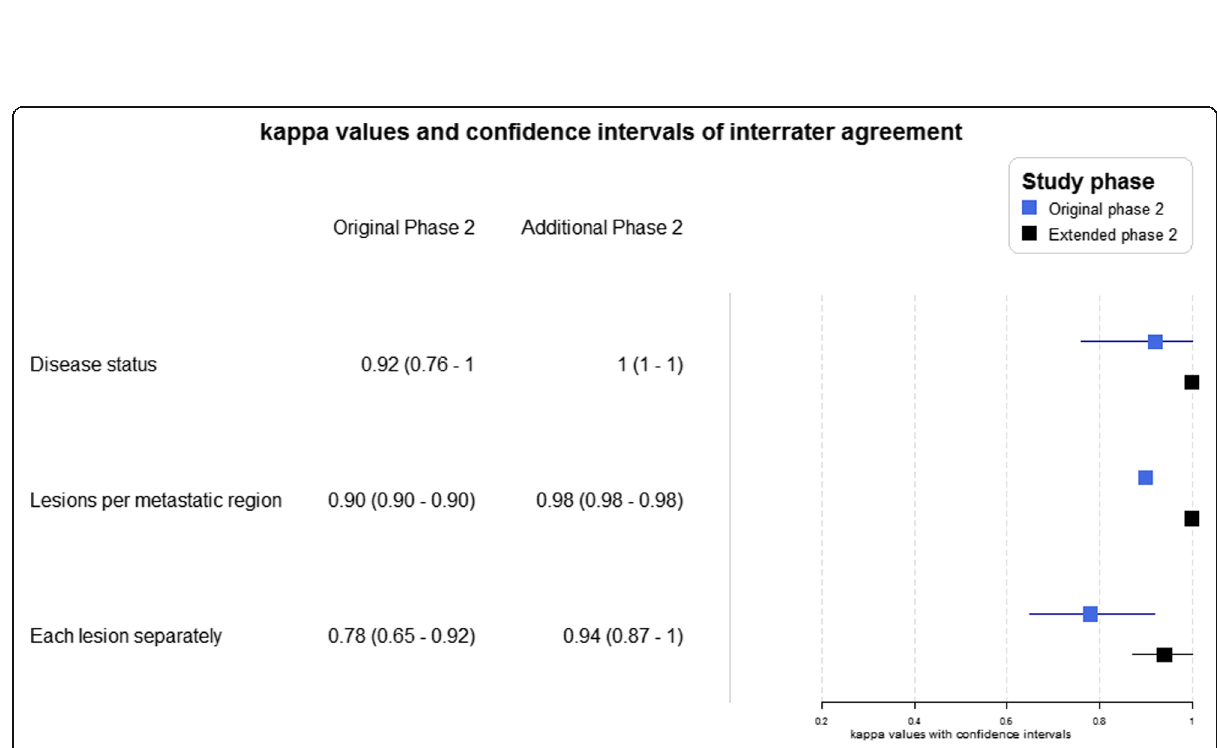
Fig. 6 Comparison of interrater reliability kappa statistics between the original Phase 2 study and the additional Phase 2